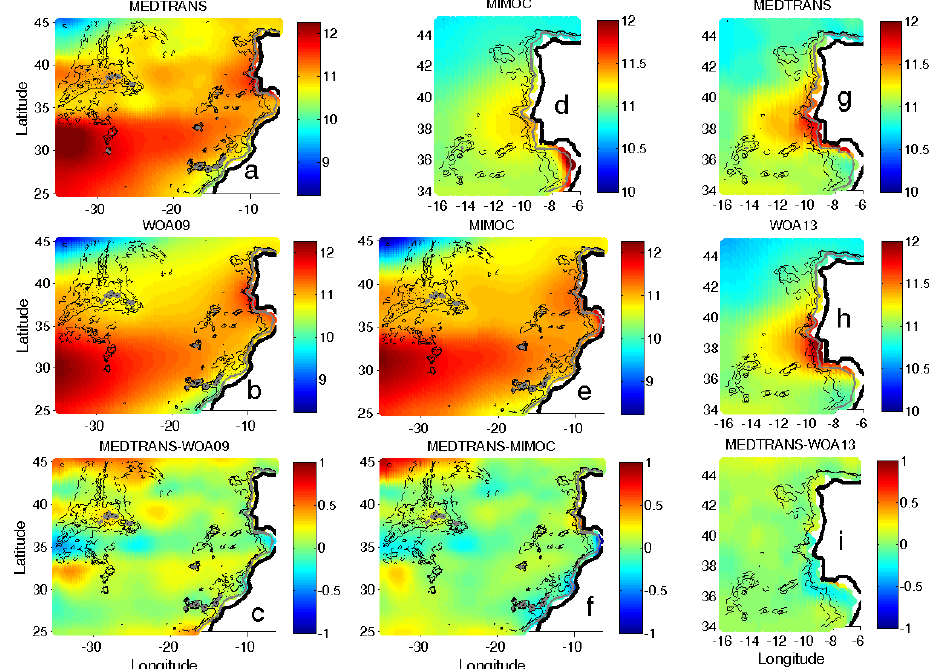
Figure 7. Temperature at 600m. All regions: (a) MEDTRANS, (b) WOA09, (c) MEDTRANS minus WOA09, (e) MIMOC, and (f) MEDTRANS minus MIMOC. Zoom to the Iberian Peninsula: (d) MIMOC, (g) MEDTRANS, (h) WOA13, and (i) MEDTRANS minus